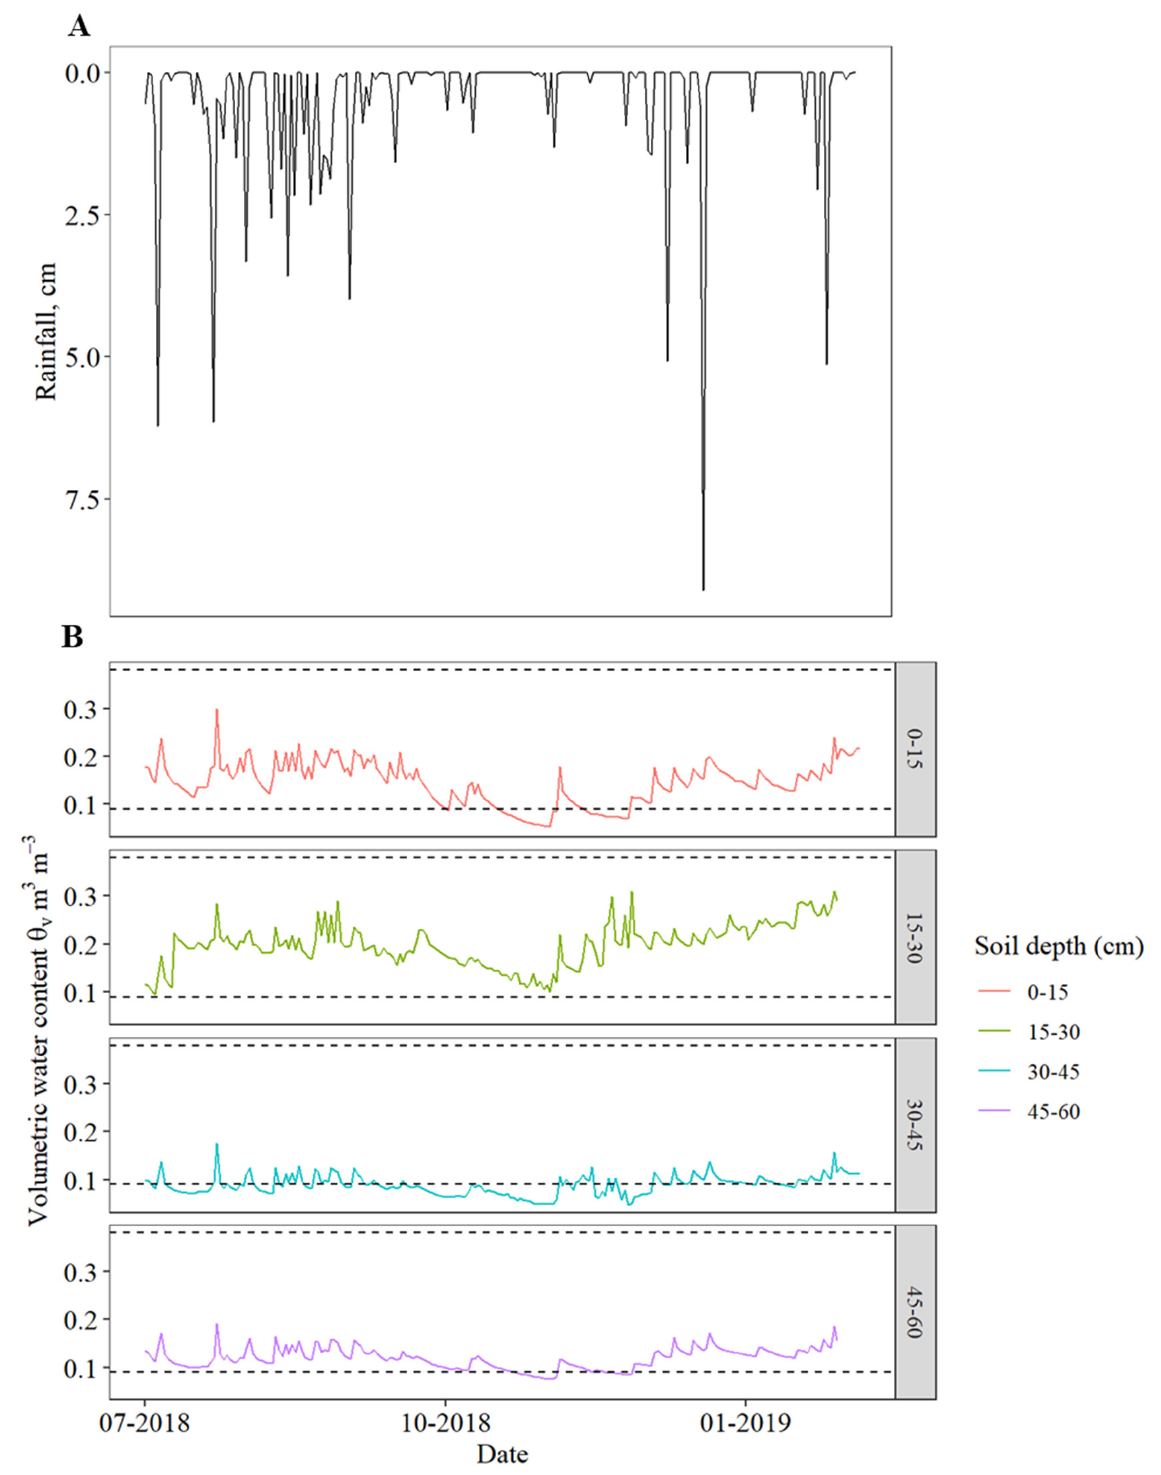
Figure 1. ( A )—Rainfall from 1 July 2018–5 February 2019; ( B )—Soil moisture distribution in the 0–60 cm depth at an increment of 15 cm, from 1 July 2018–5 February 2019. The upper and lower dash lines in each depth are water content at saturation and field capacity.